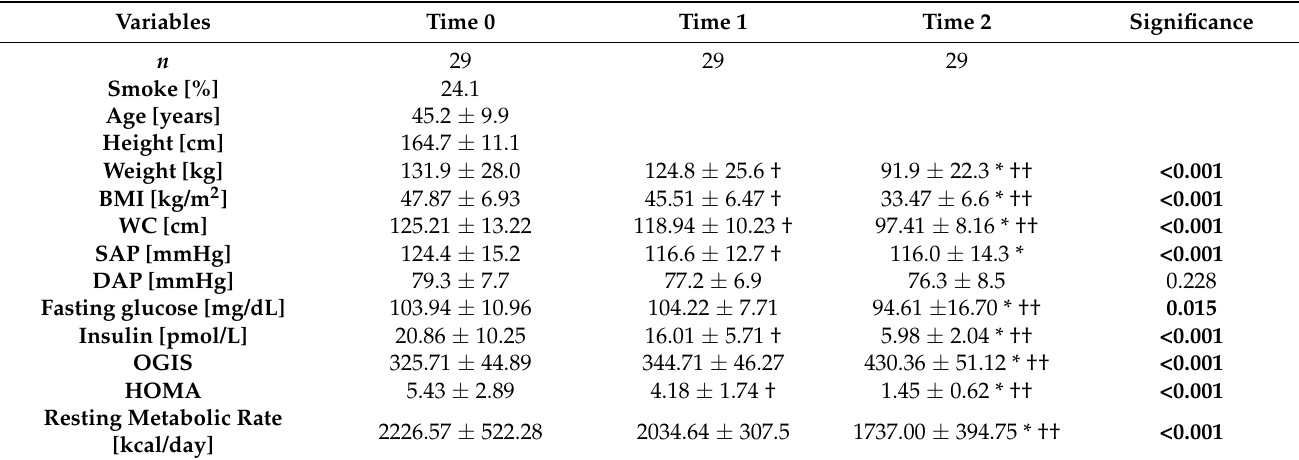
Table 1. Descriptive statistics of entire population at the three study